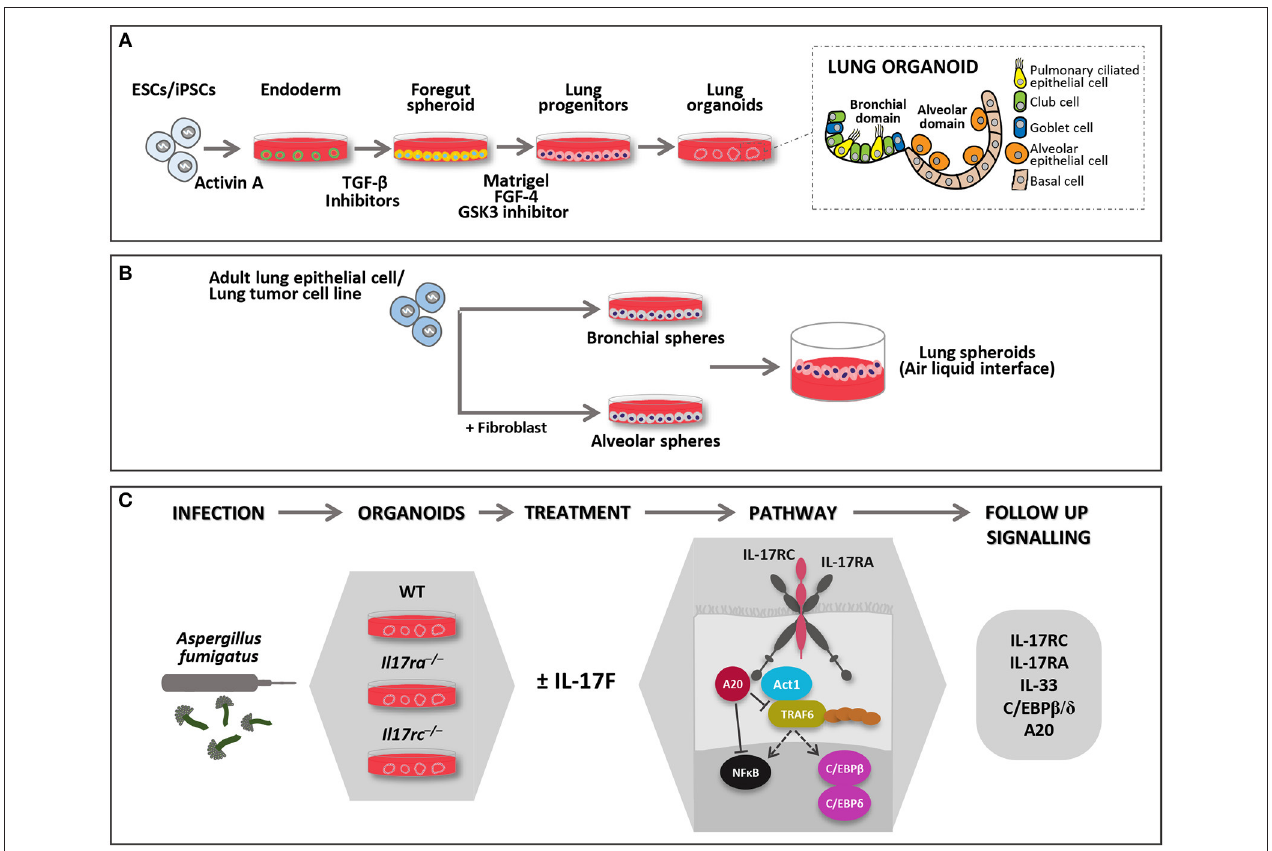
FIGURE 1 | Models of 3D lung organoid infections. Lung organoids can be developed from iPSCs or adult stem cells (upper panel). (A) iPSCs derived lung organoids: cells are differentiated into endoderm by Activin A and further to anterior foregut followed by lung progenitor spheroids through the activation and inhibition of several signaling pathways. The progenitor spheroids are further embedded in matrigel to develop 3D lung organoids when supplemented with appropriate growth factors, which resemble lung tissue in morphology and function. They form the bronchial and alveolar like domains of the lungs and has both functional (epithelial cells) and supportive (basal mesenchymal cells) pulmonary tissue. (B) Adult lung progenitor cells can form spheroids, which can be further cultured on ALI to mimic lung environment. Spheroids do not form the exact morphology and lack some of the functional cell types. They can either form alveolar or bronchial branch based on various protocols, some of them require co-culture with support cells. (C) In the lower panel, the description of an experimental model of RTIs where lung organoids derived from different genotypes may be injected with Aspergillus fumigatus. The model may be used to study IL-17R signaling pathways in 3D system where the complex role of IL-17F may be studied. FGF-4 (Fibroblast growth factor 4); GSK3 (Glycogen synthase kinase 3); TGF- β (Transforming growth factor beta